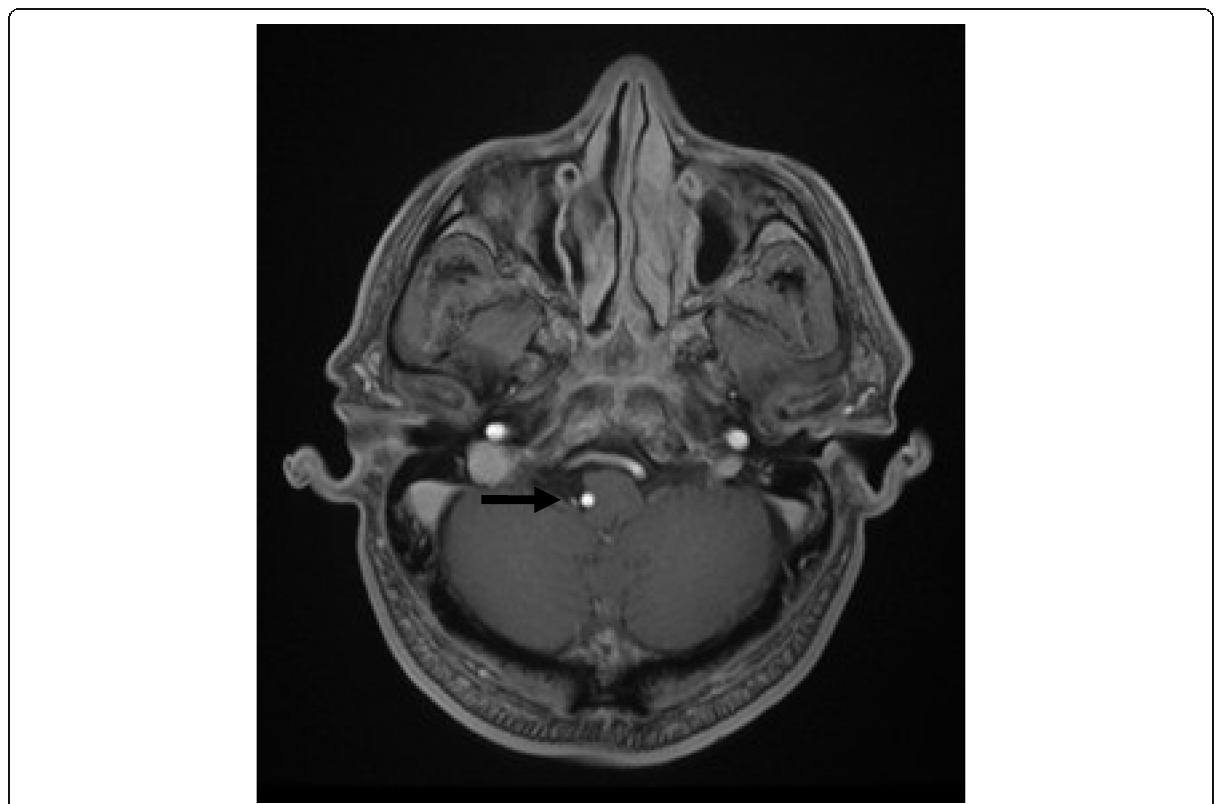
Fig. 3 Brain MRI of case (2) showed VBD compressing the MO